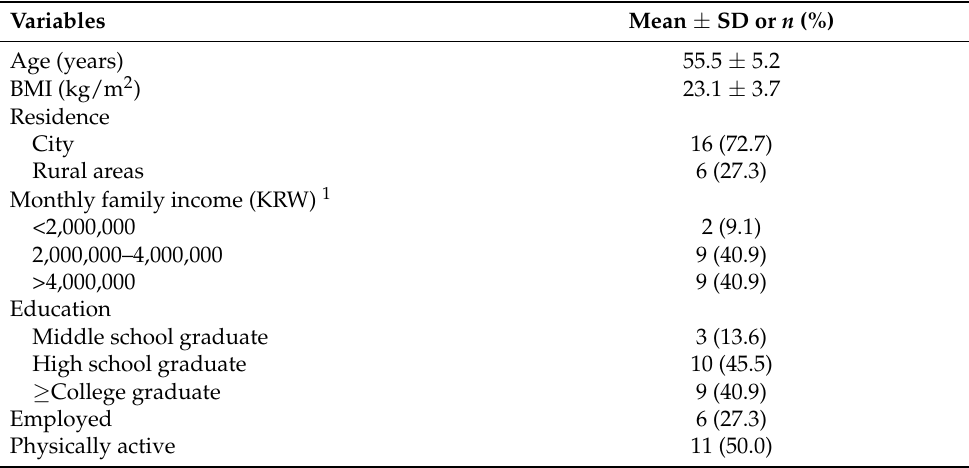
Table 2. Characteristics of participants in the 24-h dietary recall validation study ( n = 22).